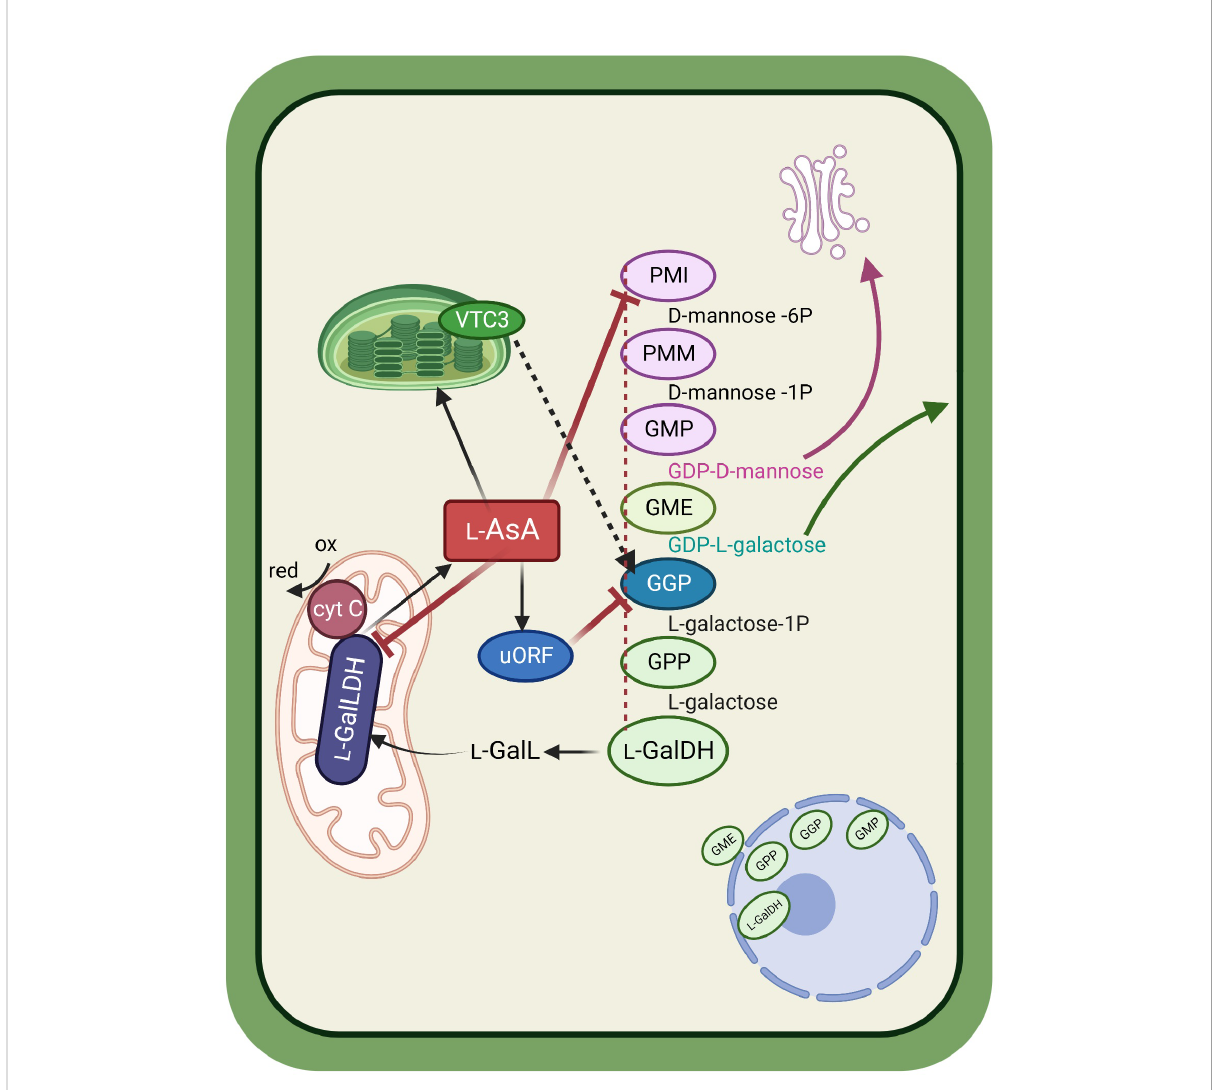
GGP (black dotted line). Nuclear co-location of 4 enzymes of the pathway could have a yet unexplored regulatory role. PMI=phosphomannose isomerase; PMM=phosphomannomutase; GMP=GDP- D -mannose pyrophosphorylase; GME=GDP- D -mannose 3 ′ ,5 ′ epimerase; GGP=GDP- L